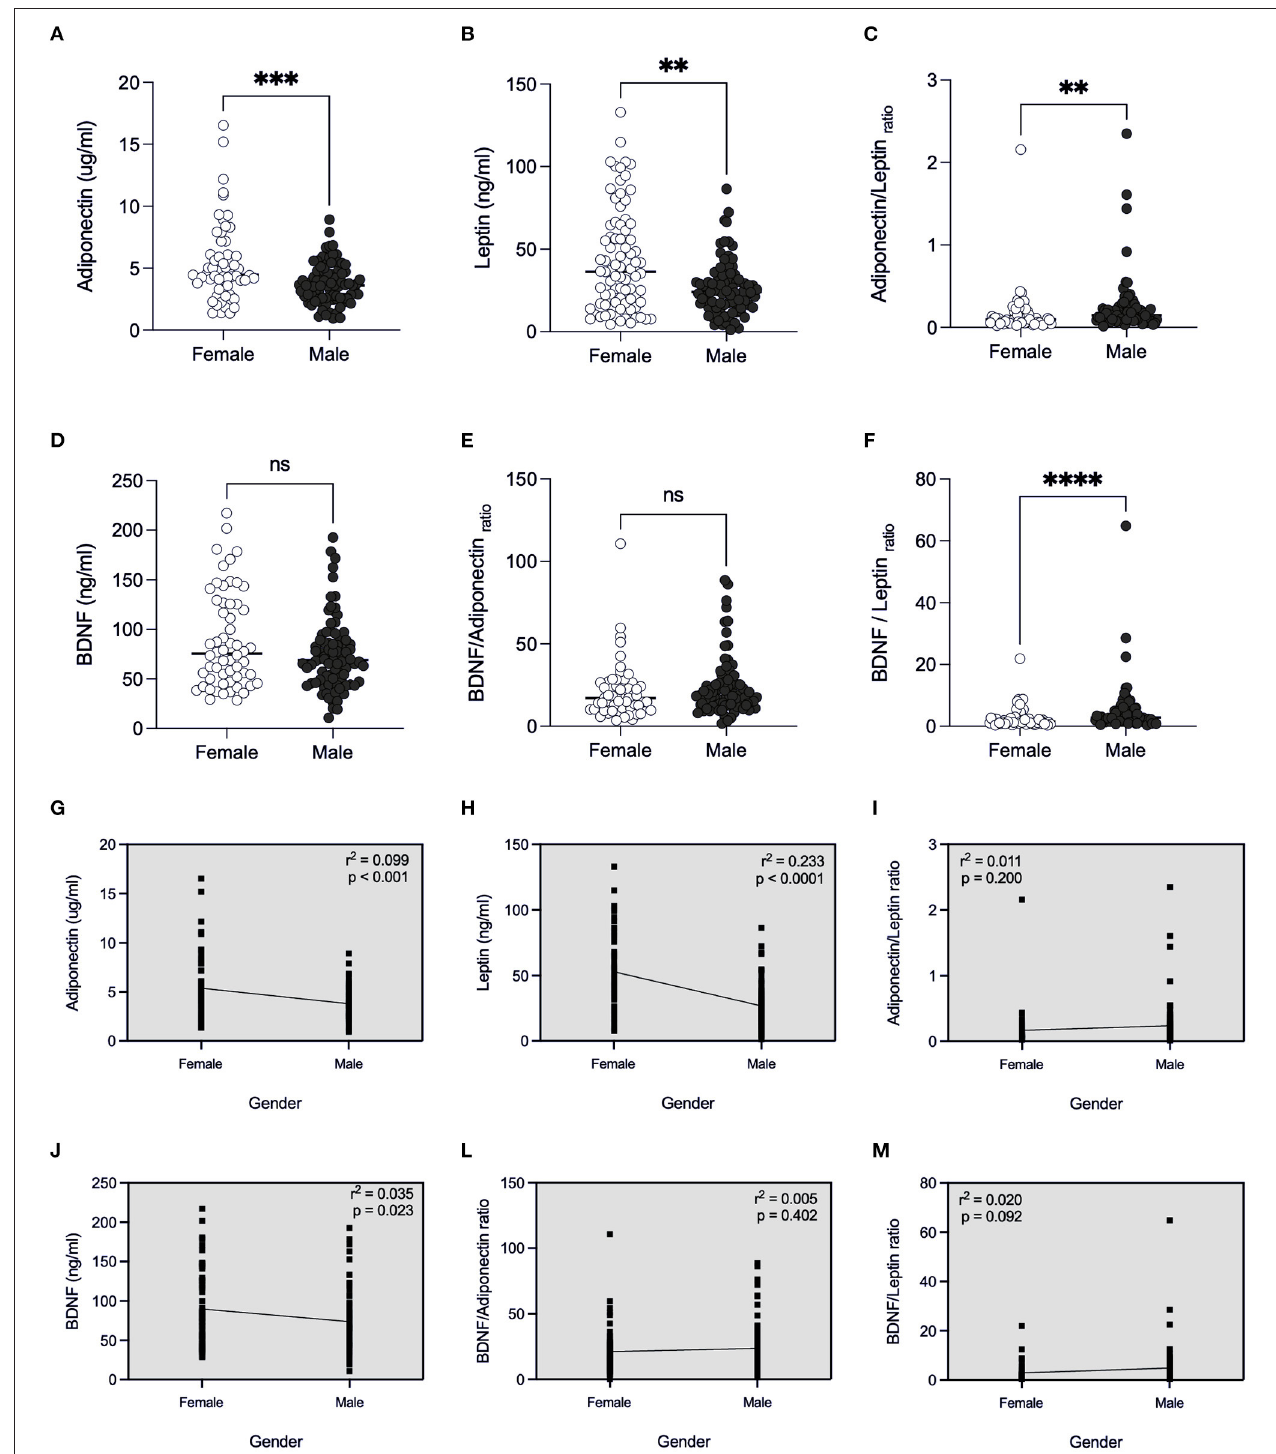
FIGURE 2 | Comparison of adipose-derived hormones levels between female and male patients with Covid-19. Values expressed as median of adiponectin (ug/ml) (A) , leptin (ng/ml) (B) , adiponectin/leptin ratio (C) , BDNF (ng/ml) (D) , BDNF/Adiponectin ratio (E) , BDNF/Leptin ratio (F) , BDNF / Adiponectin/Leptin ratio (G) were compared between two groups. Dashed box presents linear regression curve of adiponectin (G) , leptin (H) , adiponectin/leptin ratio (I) ; BDNF (J) , BDNF/Adiponectin ratio (L) , BDNF/Leptin ratio (M) as dependent variable (Y axis) with sex (female or male) as independent variable (X axis). Significance: ** p < 0.01; *** p < 0.001; **** p <